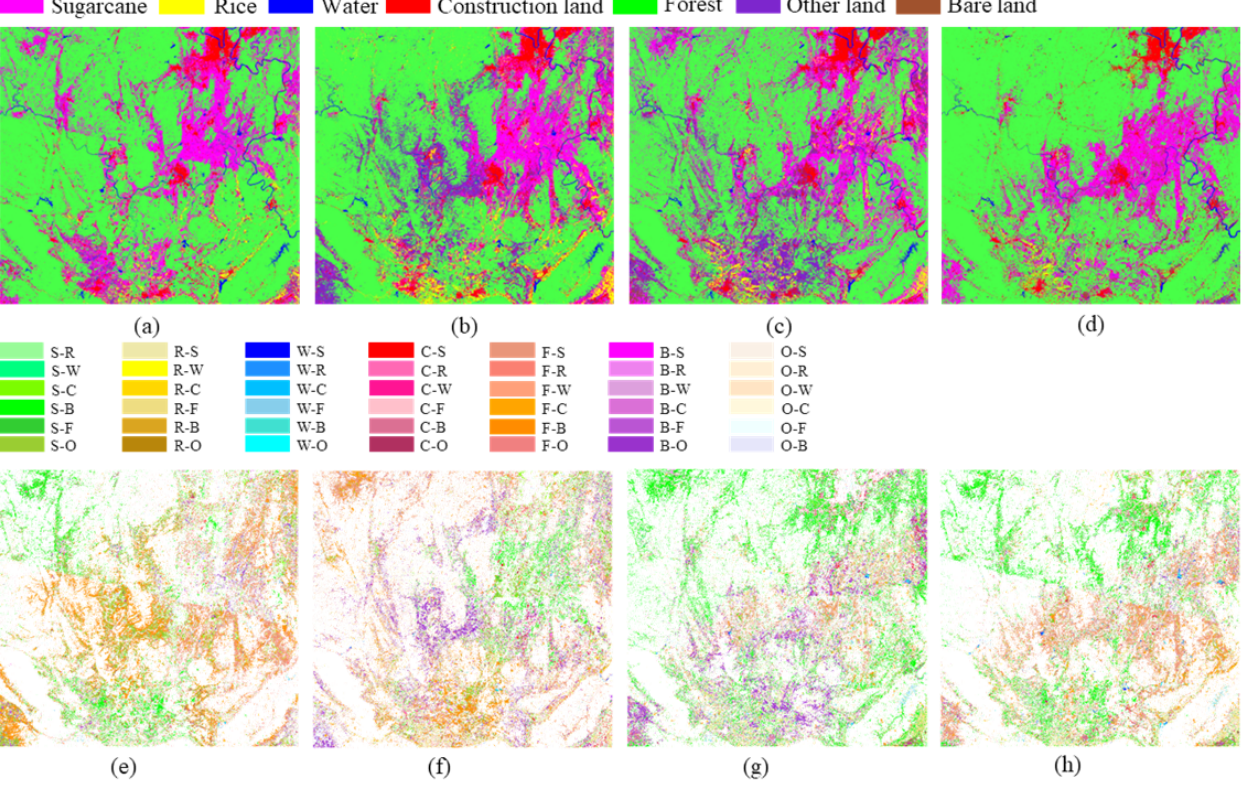
Figure 16. Spatial and temporal distribution of land use in 2015 ( a ), 2017 ( b ), 2019 ( c ), and 2021 ( d